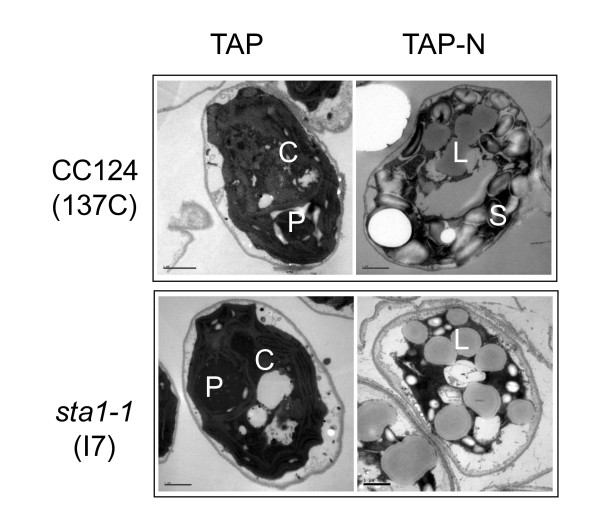
Transmission electron microscopy images of C. reinhardtii CC124 and starchless mutant sta1-1 before and after 3 days of nitrogen depletion. Bars = 1 μm. P: pyrenoid; C: chloroplast; L: lipid droplet, S: starch granule.